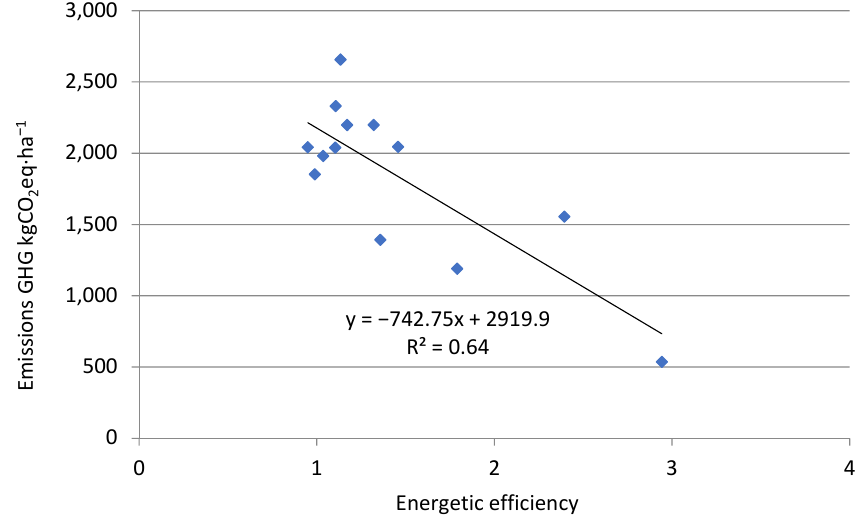
Figure 5. Relationship between the energy efficiency and GHG emissions in silage maize production technologies.